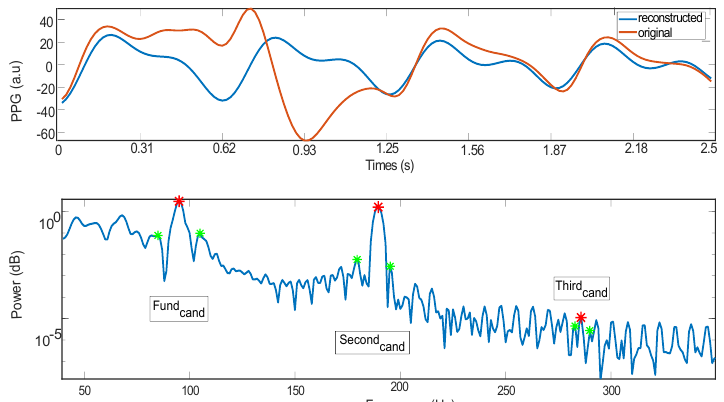
Figure 5. Example of harmonic relation estimation. In green, the candidate peaks for the fundamental, second harmonic, and third harmonic. In red, the detected fundamental, second harmonic, and third one. Fund cand : set of peaks whose frequency is less than 10 BPM away from meanHR , Second cand : set of p peaks whose frequency is closer to two times meanHR , Third cand : set of p peaks whose frequency is closer to three times meanHR . In this example, p has a value of 3.